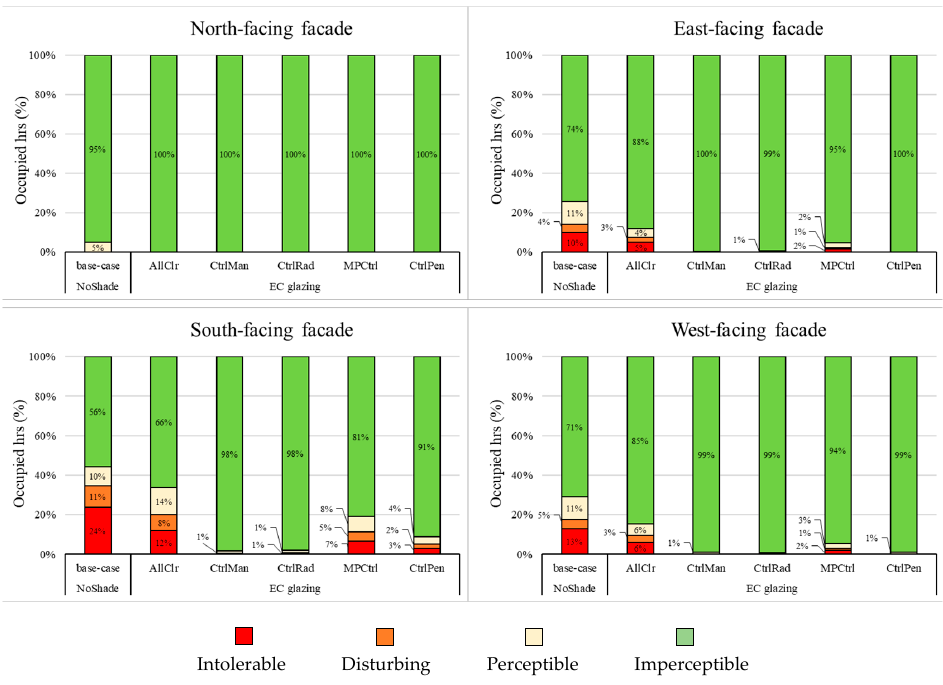
Figure 8. The overall performance of the EC glazing system in terms of discomfort glare protection for different orientations, results for occupants closer to the façade (G1).